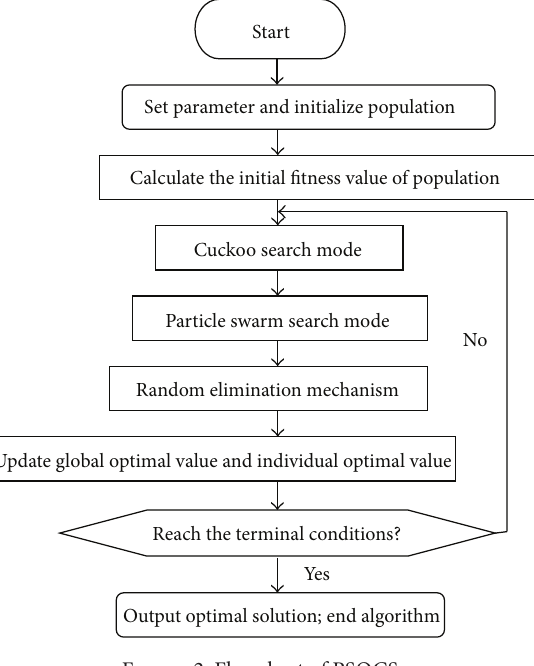
Figure 2: Flowchart of